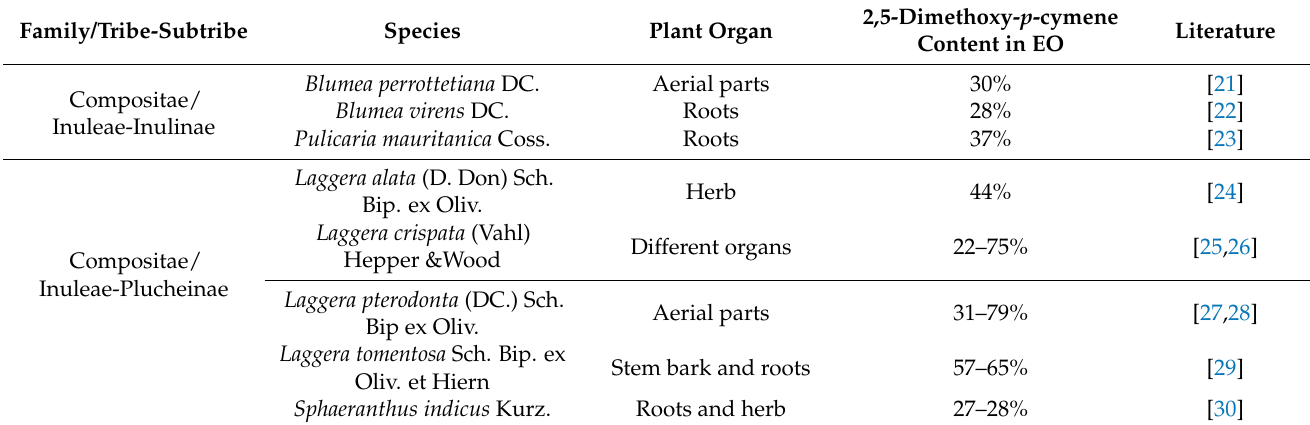
Table 4. Contents of 2,5-dimethoxy- p -cymene in essential oils (EOs) from selected species of the Inuleae.